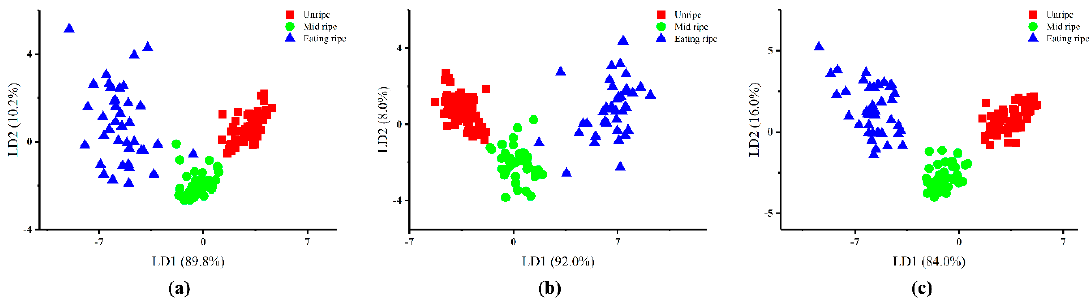
Figure 3. LDA by overall ripeness based on three different feature extraction methods: ( a ) the max/min values; ( b ) the difference values; ( c ) the 70th s values.